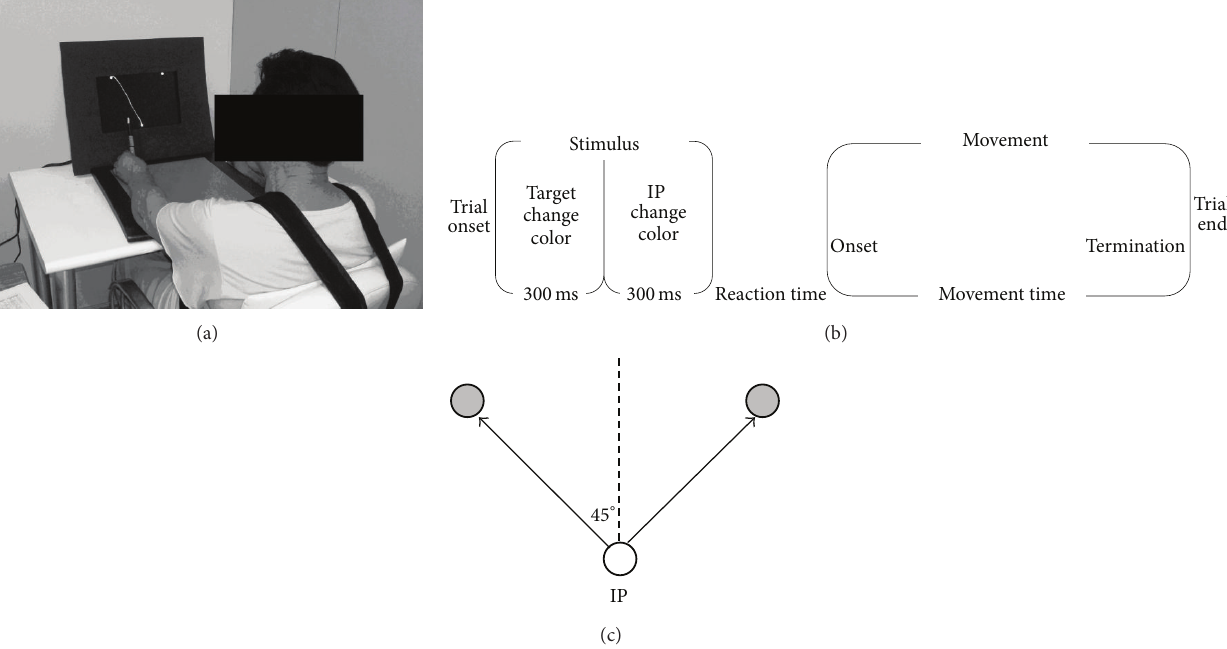
Figure 1: (a) Participant’s position. (b) Time course of each trial. (c) Targets position (gray circles) at a distance of 18 cm and 45 ∘ to the right and left of the initial position (IP, white